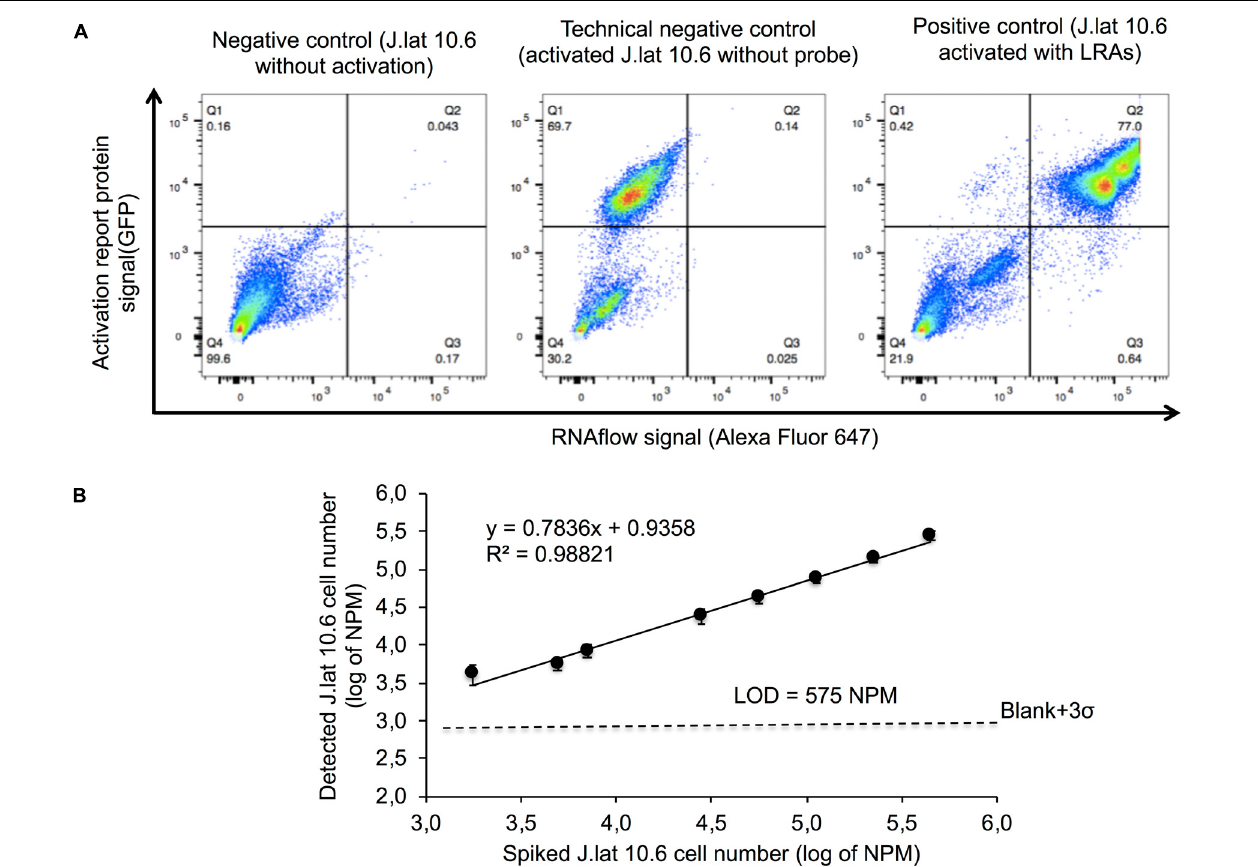
FIGURE 3 | Gating strategy and determination of the lower detection limit of RNAflow. Reactivated J-Lat 10.6 cells were spiked into parent Jurkat cells in 10-fold dilutions from 10% to 0.001% with the addition of 20% population. (A) The gating strategy for RNA positive cells (lower right panel), GFP and RNA positive cells (upper right panel) and GFP positive cells (upper left panel). Specificity of RNAflow were tested using three controls; negative control (J.Lat 10.6 Activated − / Probe + ), technical negative control (J.Lat 10.6 Activated + / Probe − ) and positive control (J.Lat 10.6 Activated + / Probe + ). (B) Detected values were compared to the predicted values to determine the linearity and Limit of Detection (LOD) of the assay which was calculated using the corresponding linear equation (y = mean blank + 3SD blank